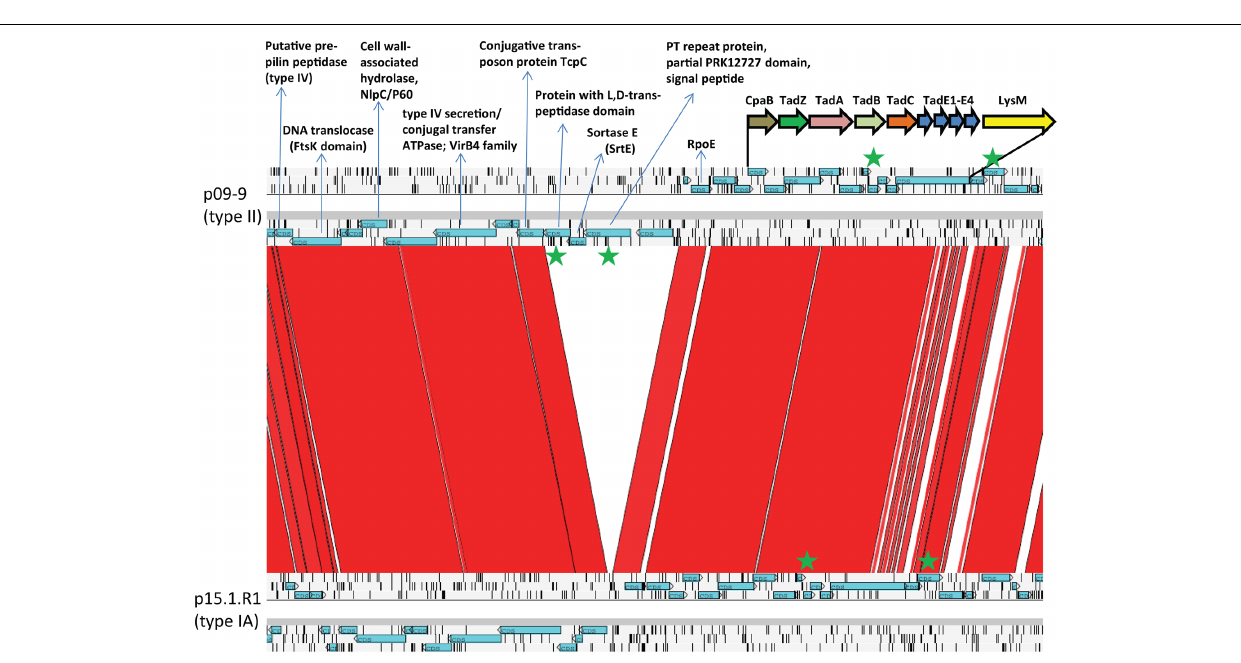
FIGURE 3 | Plasmid loci encoding possible conjugative and host-interacting functions in C. acnes and their detection in cell surface and secreted fractions. Present on all plasmids is a tad locus encoding the biosynthesis of Flp/type IVb pili. In addition, all plasmids encode functions related to their conjugative transfer. A type II-specific locus was identified that encodes secreted or surface-exposed proteins. The comparison of the loci of p09-9 and p15.1.R1 and was done with ACT; regions of high similarity between the two plasmids is represented in red. Highlighted (green stars) are the genes whose proteins were detected by mass spectrometry in secreted and surface-exposed cell